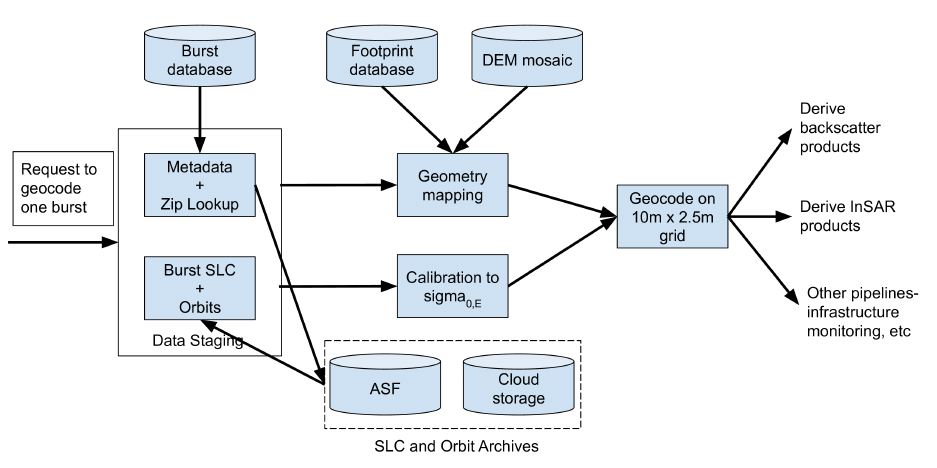
Figure 1. Sentinel-1 burst geocoding